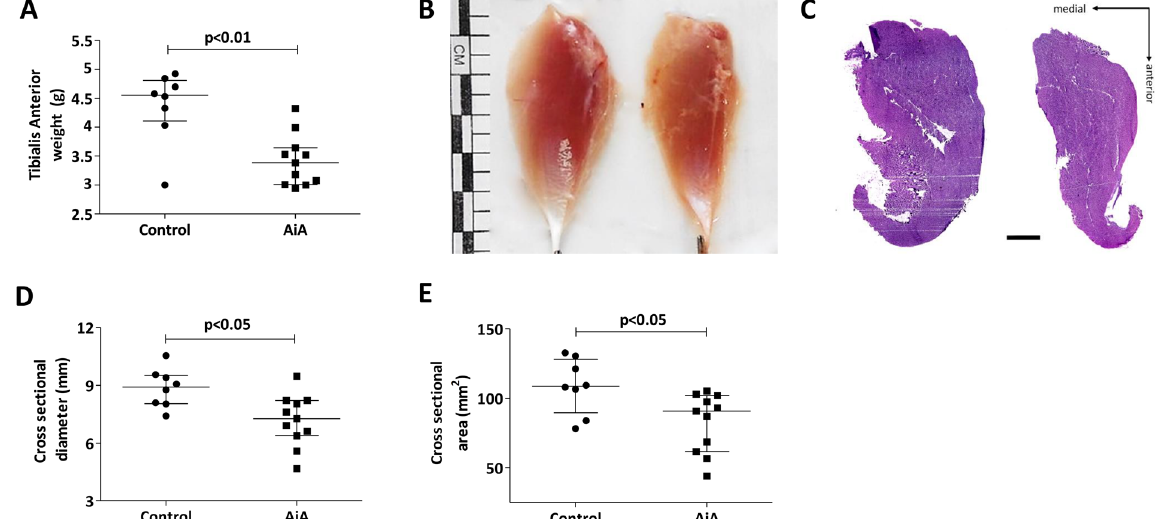
Figure 2. Alterations in skeletal muscle structure. ( A ) Tibialis Anterior (TA) weight (g). ( B ) Representative TA from healthy control (left) and antigen-induced arthritis (AiA) (right) groups illustrating reduced whole muscle size. Posterior view, scale bar = 1 cm. ( C ) Representative mid-belly cross-sections of TA in control (left) and AiA (right) groups stained with Harris haematoxylin and eosin. Scale bar = 2.5 mm. ( D ) Cross sectional diameter of TA (mm). ( E ) Cross sectional area of TA (mm 2 ). Data represent individual values; medians with IQRs are also indicated (n = 8–11 rabbits per group).